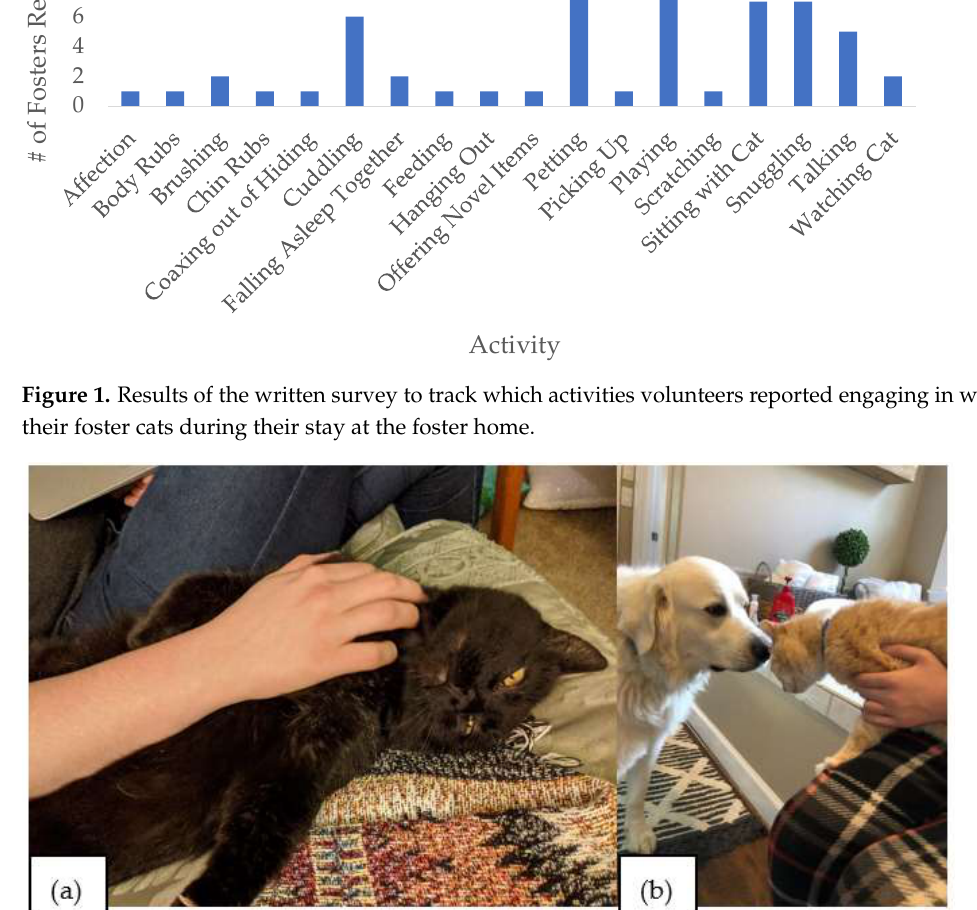
Figure 2. Photos of cats while at the foster home. ( a ) Displays a cat sitting next to their foster while receiving petting. ( b ) Displays a foster cat being introduced to a cat-friendly dog, the foster cat responds by rubbing their